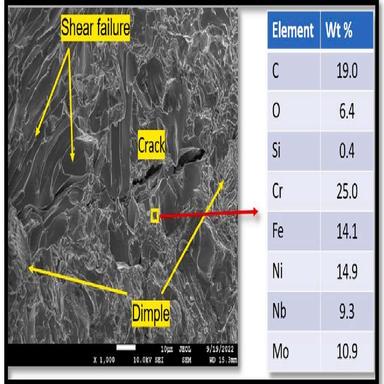
SEM image of fracture surface.